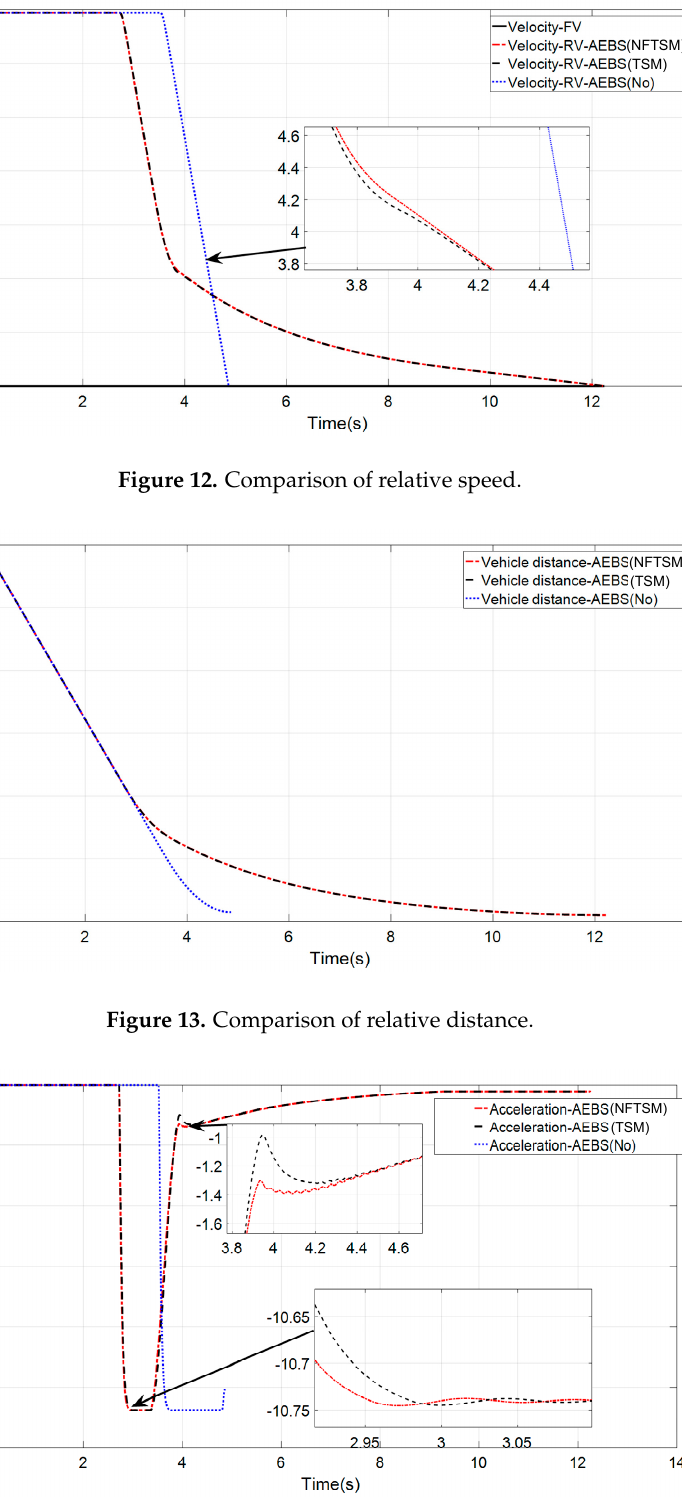
Figure 15. Comparison of 1 TTC − .